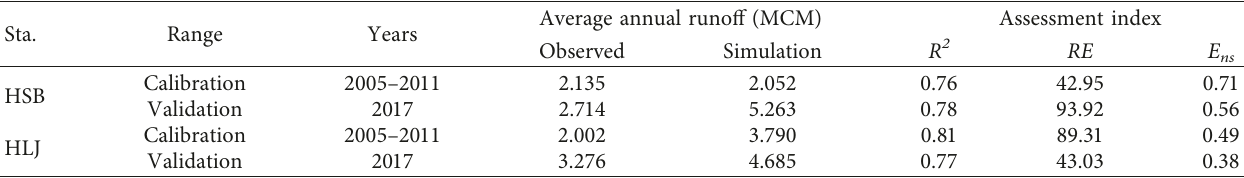
Table 12: Effective indexes of the SWAT